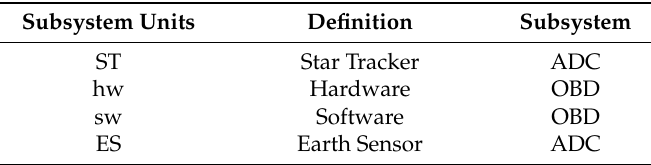
Table 10. Subsystem Units Codification.